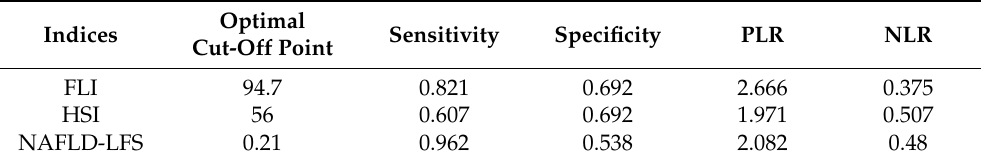
Table 6. The optimal cut-off values for liver fat indices and their sensitivity and specificity for the identification of NAFLD in diabetic patients.